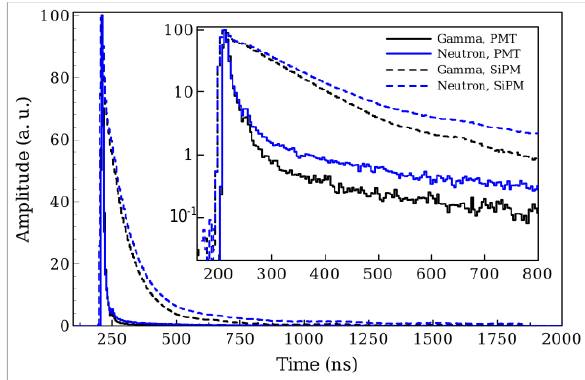
Fig. 4. Neutron and gamma average signals coming from the PMT anode and preamplifier output (NUV-SiPM) using an EJ-299 (20 mm dia. x 20 mm